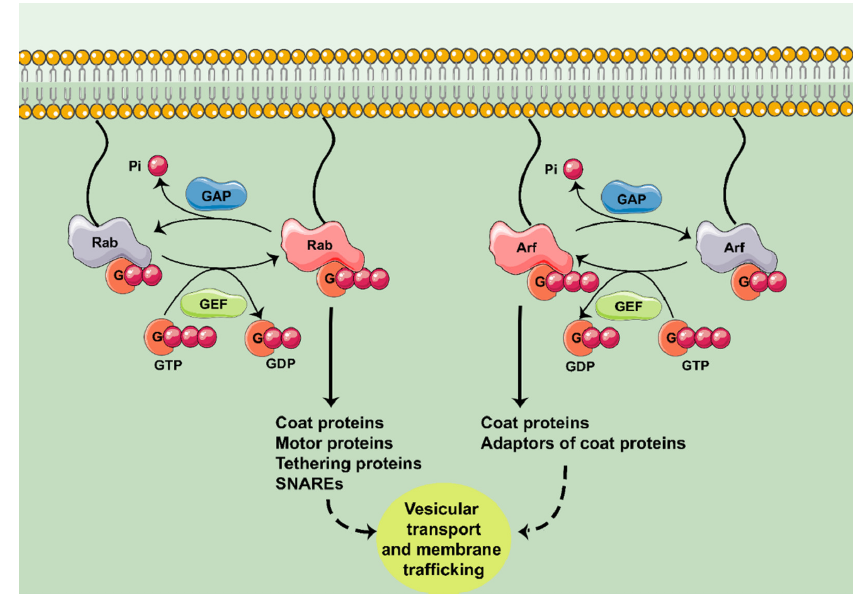
Figure 1. Rab and Arf GTPases and their role in membrane trafficking. Rab and Arf GTPases are activated by guanine exchange factors (GEF). Once activated, they interact with their effector molecules. Rab GTPases can interact with coat proteins, motor proteins, tethering proteins and SNAREs; Arf GTPases interact with coat proteins and adaptors. This results in the control of vesicle transport and membrane trafficking. The cycle culminates by the inactivation of the GTPase by GTPase activating proteins (GAP). G: